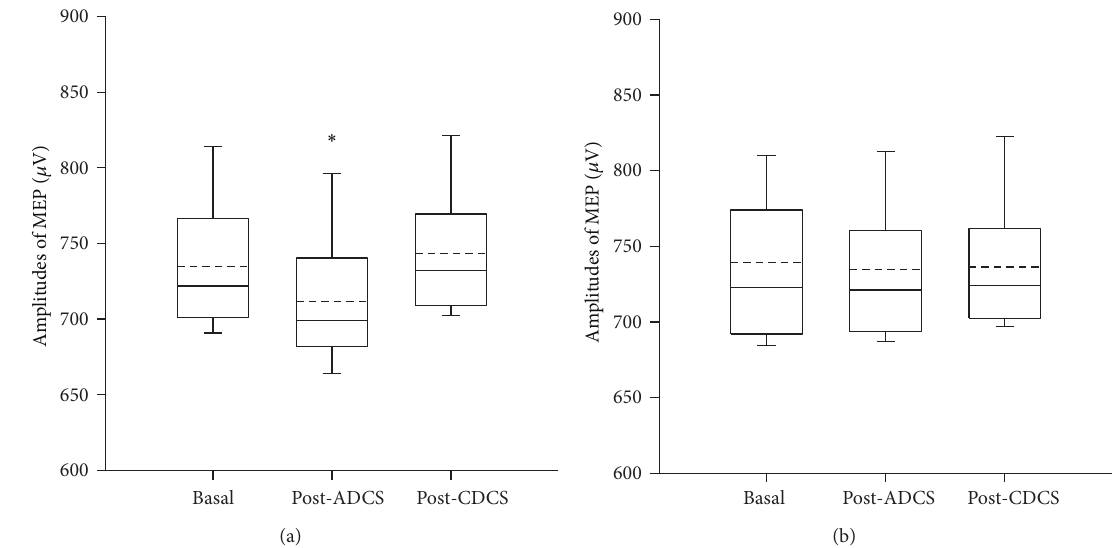
Figure 3: Box and whisker plots showing the effects of direct current stimulation applied over left cerebellar hemisphere on the amplitudes of corticomotor responses. Left and right panels correspond to values from left gastrocnemius muscle (a) and right gastrocnemius muscle (b), respectively. Basal: values in basal condition; post-ADCS: values obtained after application of anodal direct current stimulation over the dura; post-CDCS: values obtained after application of cathodal direct current stimulation over the dura. Medians (continuous lines) and means (dashed lines) are illustrated, as well as outliers (corresponding to the 5th and 95th percentiles). In left gastrocnemius muscle, values at baseline and values after CDCS are significantly higher as compared to the values obtained after ADCS. ∗ 𝑃 < 0.05 ( 𝑛 = 13